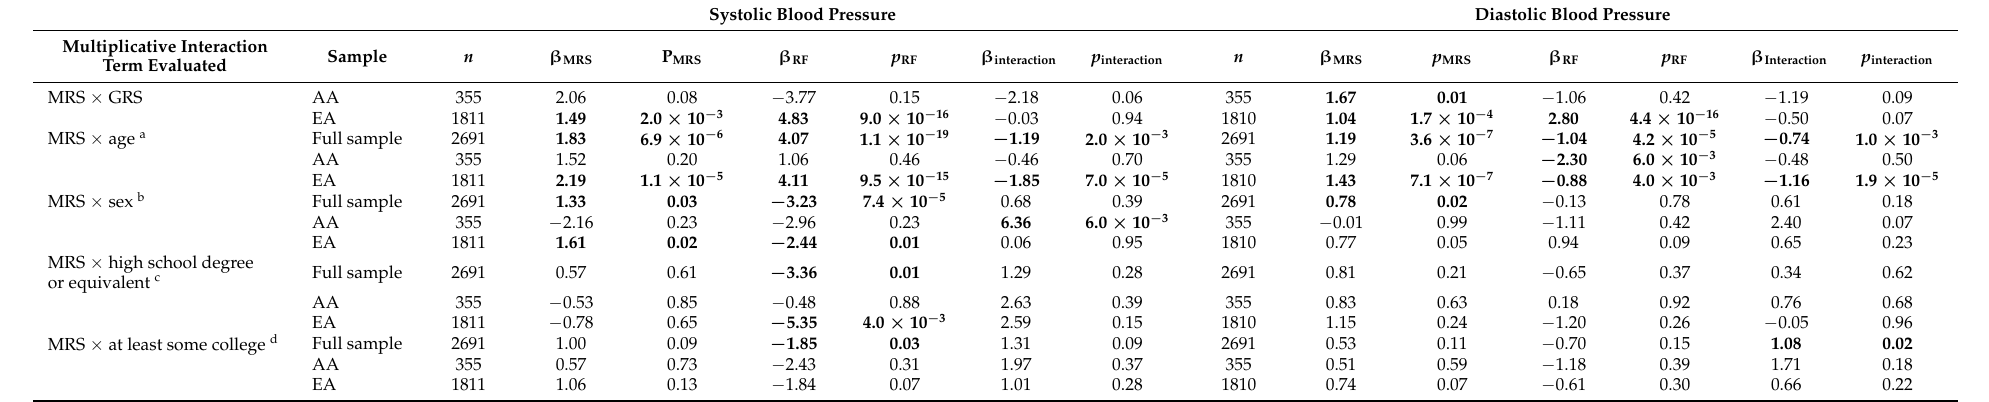
Table 6. Interaction analysis between blood pressure methylation risk scores and risk factors by ancestry in the Health and Retirement Study. Systolic Blood